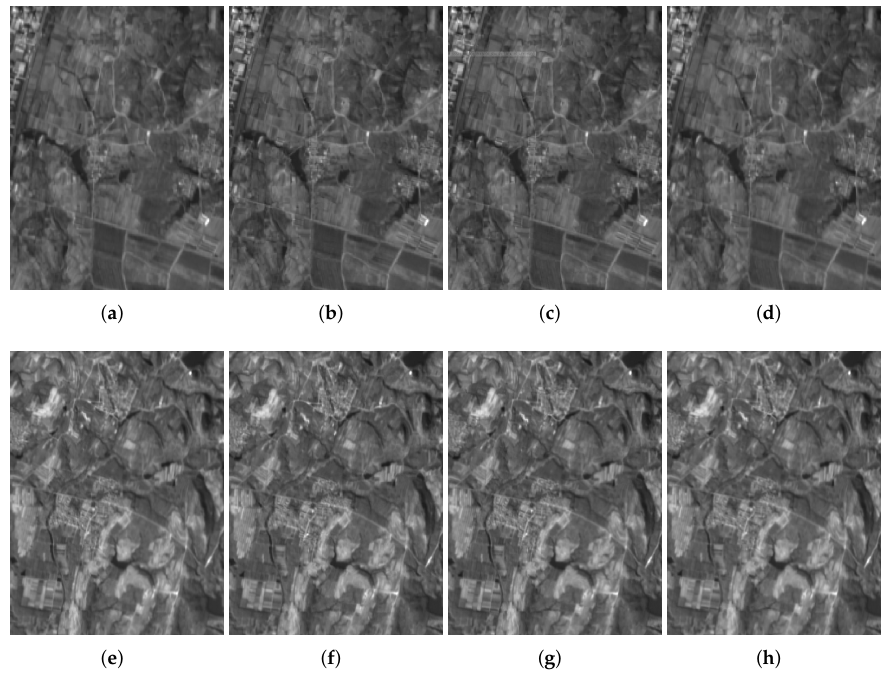
Figure 13. Stitching results for Image Data 2 with different methods: ( a ) traditional line-time nor- malization, ( b ) line-based line-time normalization, ( c ) block-based line-time normalization, ( d ) scene- based line-time normalization, ( e ) traditional line-time normalization, ( f ) line-based line-time normal- ization, ( g ) block-based line-time normalization, ( h ) scene-based line-time